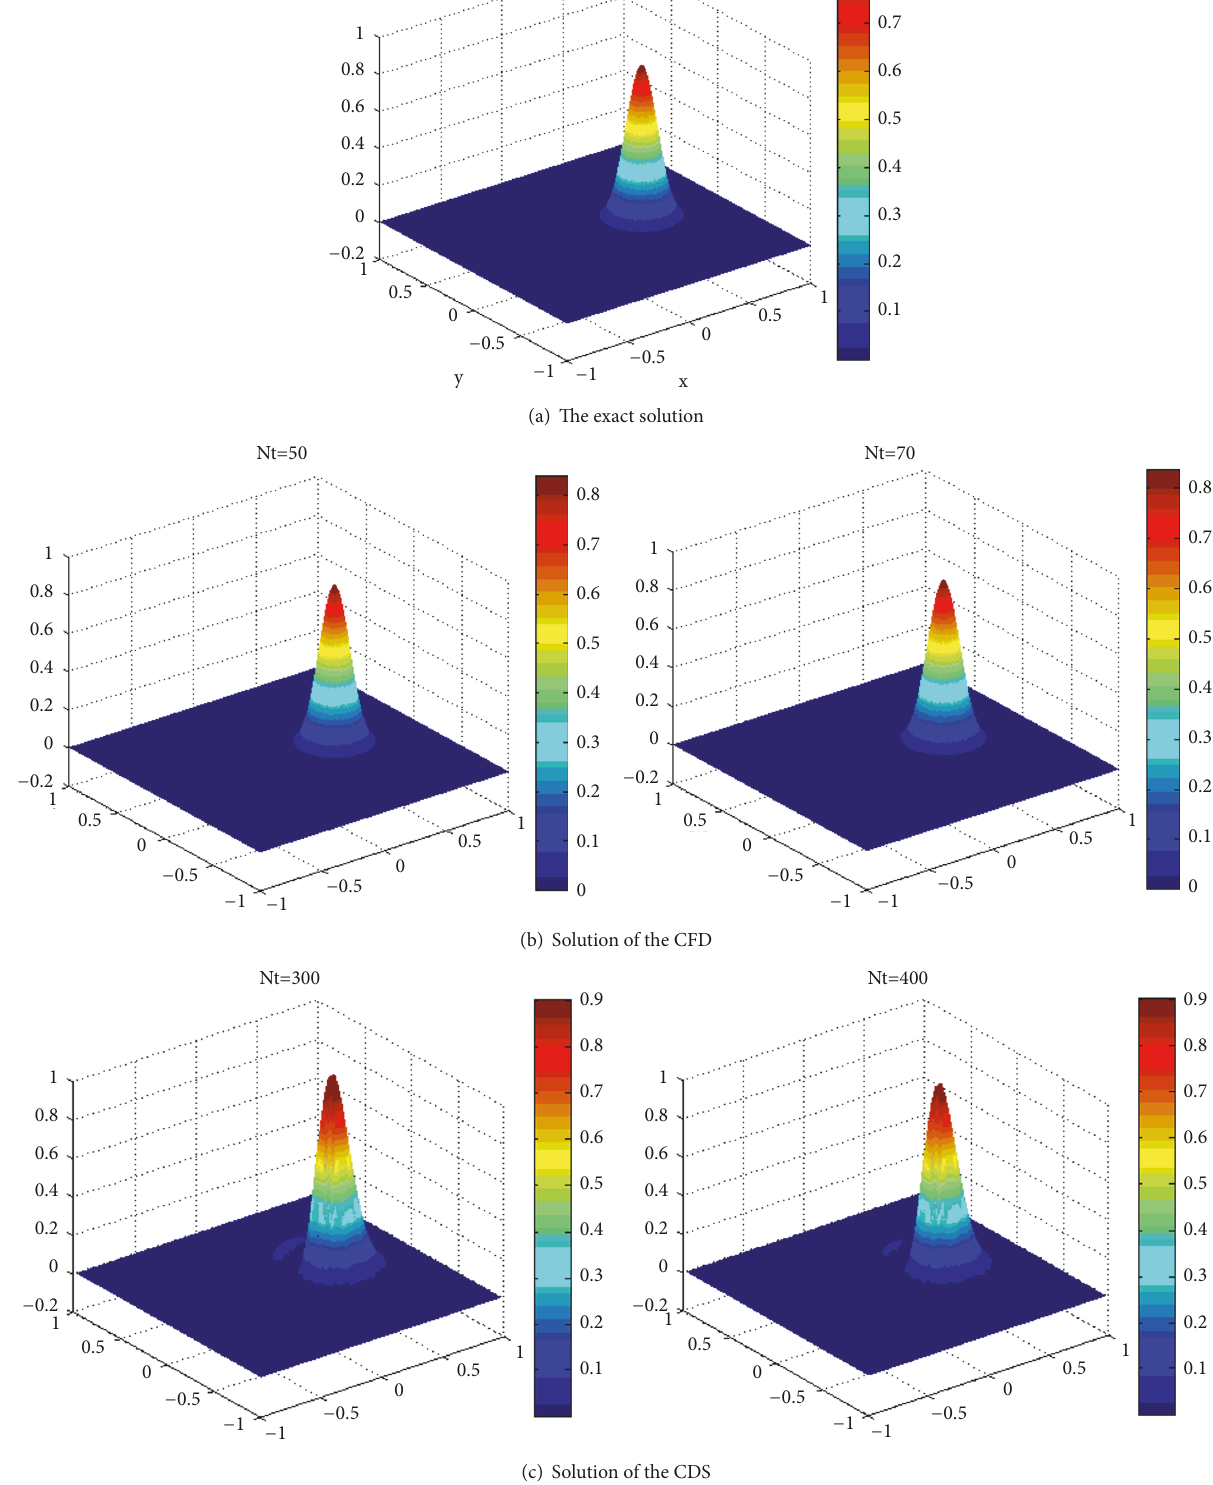
Figure 2: The exact solution and approximate solutions of different schemes with different time